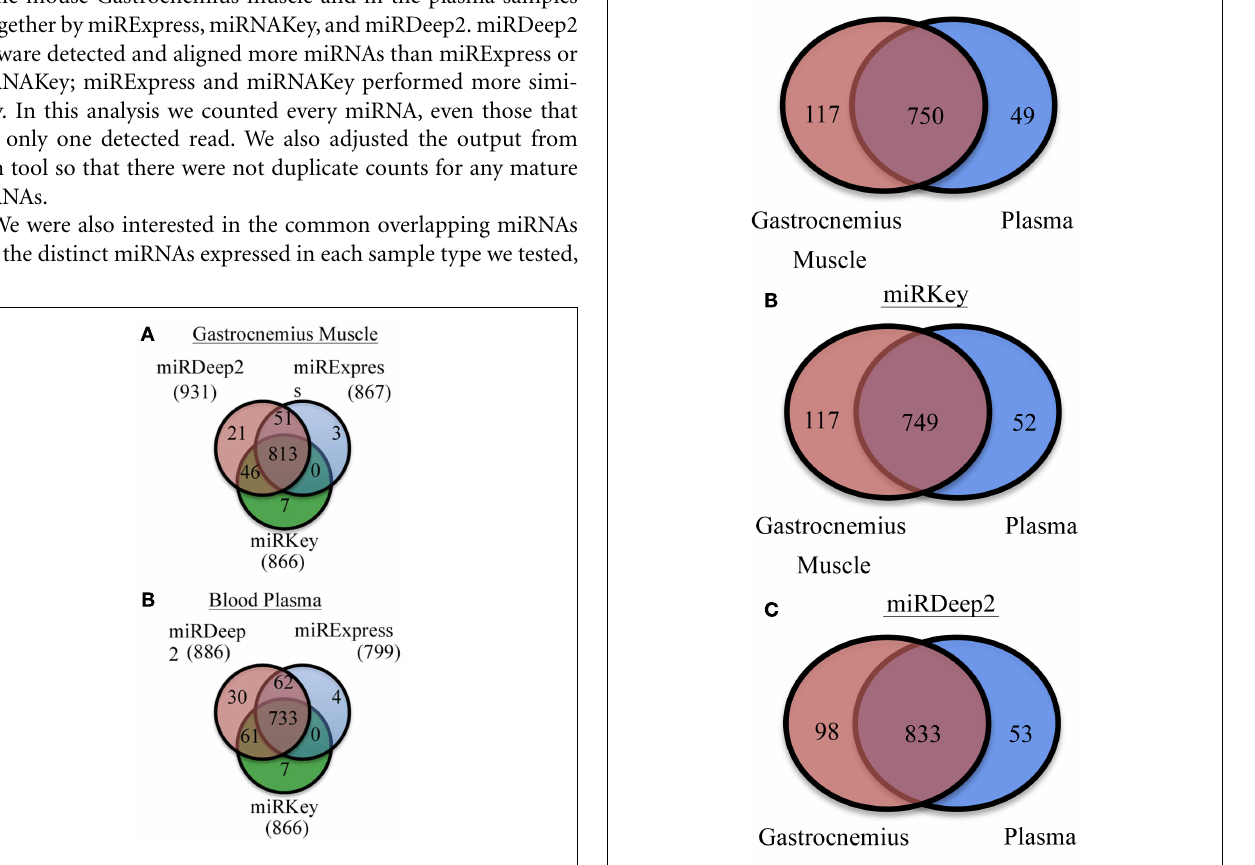
FIGURE 2 | Unique and overlapping miRNAs detected by each of the three programs for two sample types. (A) Results of miRKey, miRDeep2, miRExpress detection of miRNAs in the Gastrocnemius muscle samples. Venn diagram displays the overlapping and unique number of miRNAs detected by each program. (B) Results of miRKey, miRDeep2, miRExpress detection of miRNAs in the plasma samples.Venn diagram displays the overlapping and unique number of miRNAs detected by each program.